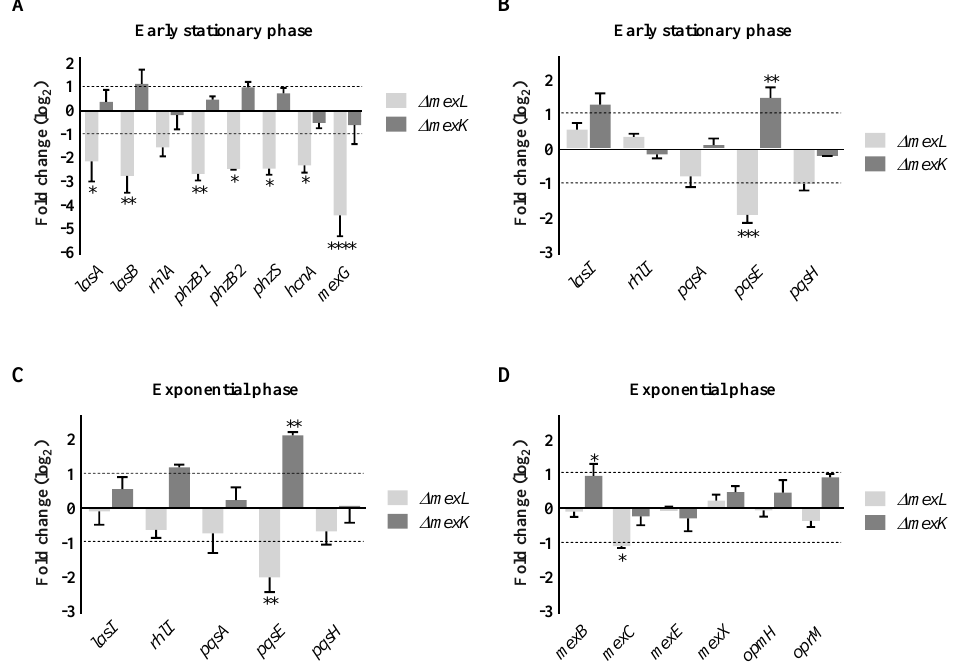
Figure 4. Overexpression of the MexJK efflux system affects the expression levels of QS signaling genes. Total RNA was extracted for PAO1, ∆ mexL , and ∆ mexK at ( A , B ) early stationary (OD 600 = 2.5) and ( C , D ) exponential phases of growth (OD 600 = 0.6). The expression was determined by RT-qPCR for ( A ) genes regulated by QS, ( B , C ) genes responsible for QSSMs production, and ( D ) genes belonging to various RND pumping systems. The figure represents the fold change of the expression of these genes in the ∆ mexL or ∆ mexK strains, with respect to the one observed in PAO1. Values that are significantly different by an unpaired two-tail t -test are indicated by asterisks as follows: * p < 0.05; ** p < 0.01; *** p < 0.001; **** p < 0.0001.